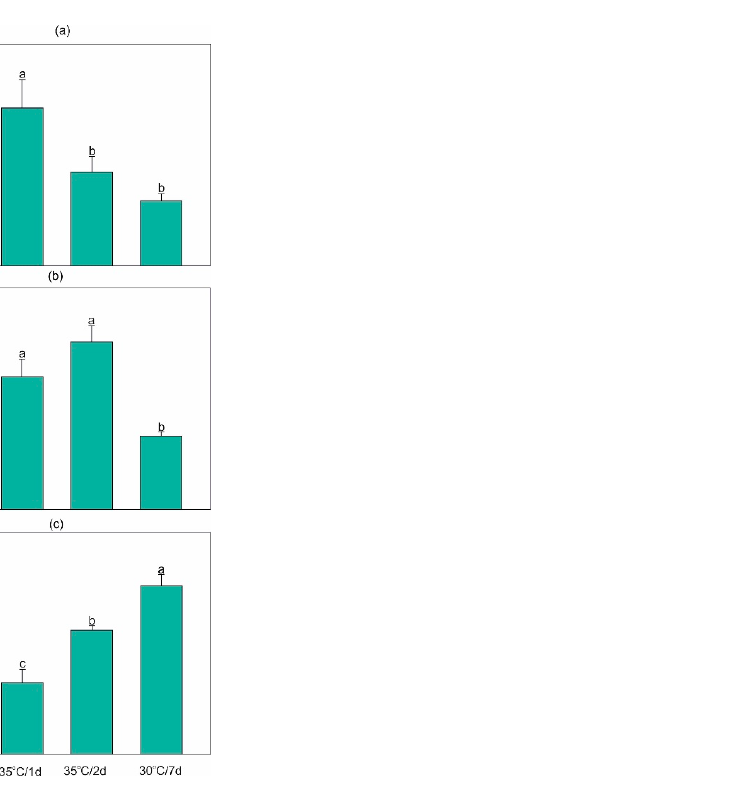
Figure 5. Changes in the contents of selected secondary metabolites ( a ) kaempferol, ( b ) chlorogenic acid, and ( c ) anthocyanins in H. sosnovskyi in response to stress temperature. Data are means ± SE ( n = 4). Values followed by the same letter(s) are not significantly different according to Tukey’s test ( p < 0.05). Table 1. Effect of high temperature on the content of flavonols and phenols and antioxidant capacity in H. sosnowskyi . Data are means ± SE ( n = 4). Values within the columns followed by the same let- ter(s) are not significantly different according to Tukey’s test ( p < 0.05).